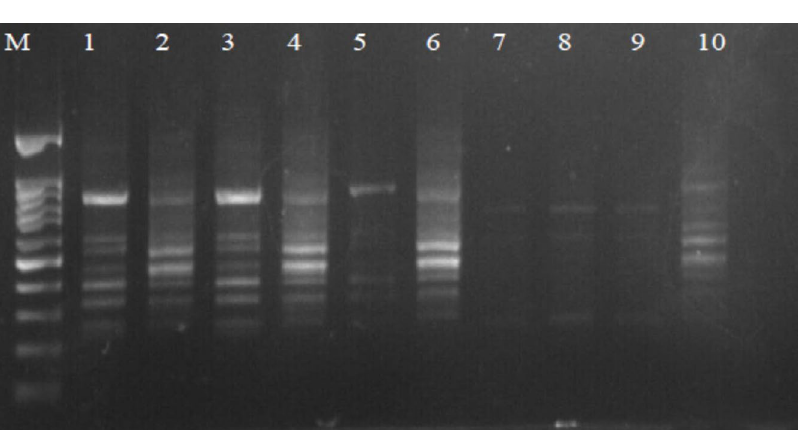
Fig. 3. Agarose gel electrophoresis of OPA-18 amplified product. The electrophoresis pattern of genomic DNA extracted from fenugreek ( Trigonella foenum-graecum ) leaf samples: 1, control; 2, Th-1; 3, Th-2; 4, AVG; 5, MeJA; 6, Th-1 + AVG; 7 Th-1 + MeJA; 8, Th-2 + AVG; 9, Th-2 + MeJA; 10, MeJA + AVG; M, DNA size marker. Electrophoresis conditions: 1% agarose concentration, 75 V, 20 mA for 120 min, stained with ethidium bromide.